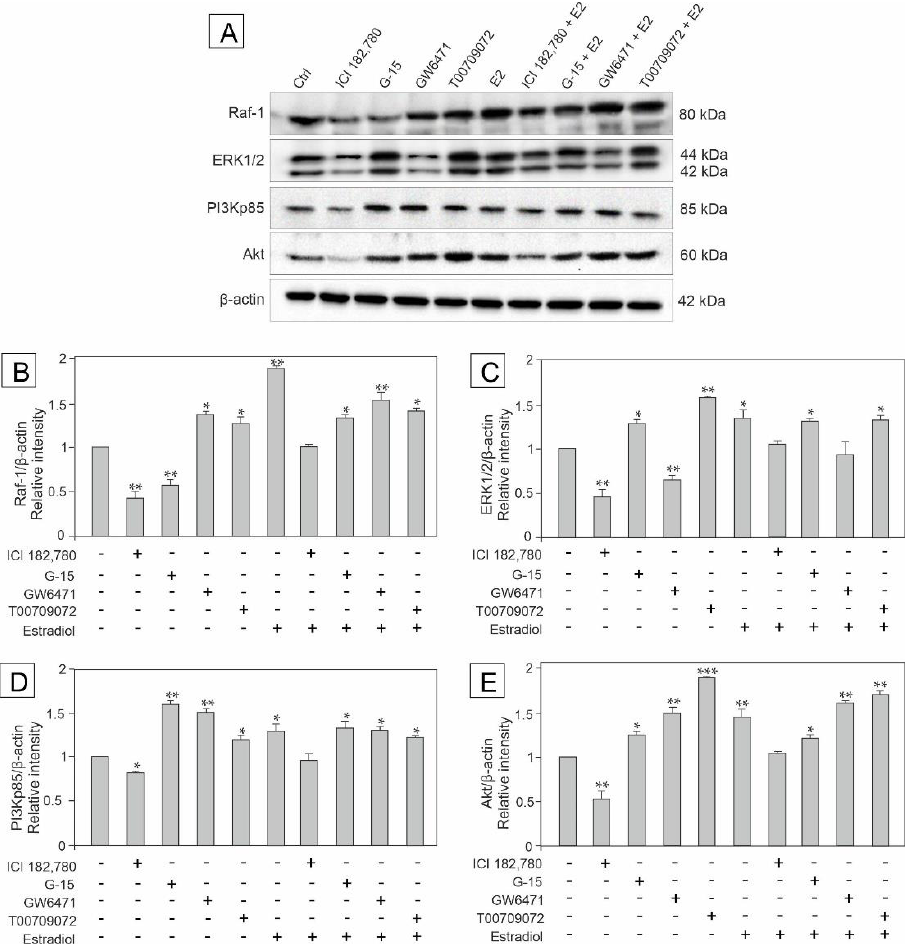
Figure 2. The effect of GPER agonist (ICI 182,780), GPER antagonist (G-15), PPAR α antagonist (GW6471), PPARγ antagonist (T00709072) and estradiol (E2) on Raf -1, ERK 1/2, PI3Kp85, and Akt protein expression in mouse testis explants ( A – E ). Representative blots of Western analysis ( A ) and relative expression of the proteins ( B – E ). Explants were harvested after 24 h. Untreated explants served as a control. Protein levels within control testis explants were given a value of 1. The cropped blots are displayed and the original blots are provided in Supplementary Materials (Figure S1). The relative levels of the proteins were normalized to β -actin which served as internal protein loading control. The histograms are the quantitative representation of data (mean ± SD) of three independent experiments, each in triplicate ( B – E ). A plus sign (+) indicates the presence of the compound in the culture medium, a minus sign ( – ) indicates no compound in the culture medium. Asterisks indicate significant differences from control explants. Values are denoted as * p < 0.05, ** p < 0.01 and *** p < 0.001.